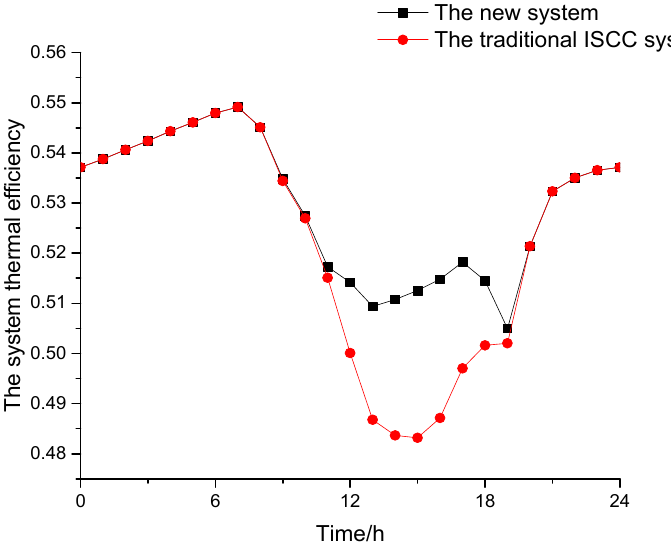
Figure 12. The system thermal efficiencies of the traditional ISCC and the new system in a typical summer day.